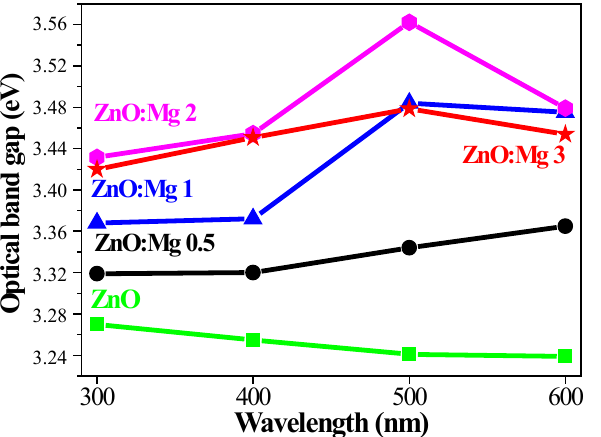
Figure 12. Optical band gap of ZnO and ZnO:Mg films as a function of the annealing temperatures . The shrinkage of the optical band gap with annealing temperature can be due to the improved crystallization, the decreased defects of the film structure and greater crystal- lite sizes. Similar results have been reported in the literature [71].